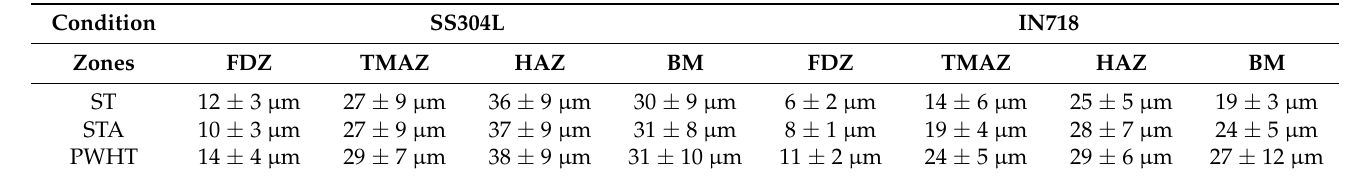
Table 4. Average grain sizes of the various zones in friction welded SS304L/IN71.